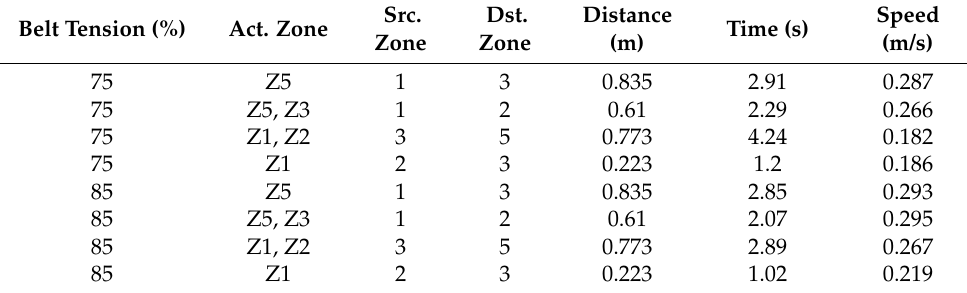
Table 6. Dynamic case results for 75–85% belt tension with active Table 5. Dynamic case results for 75–85% belt tension with no active zones.